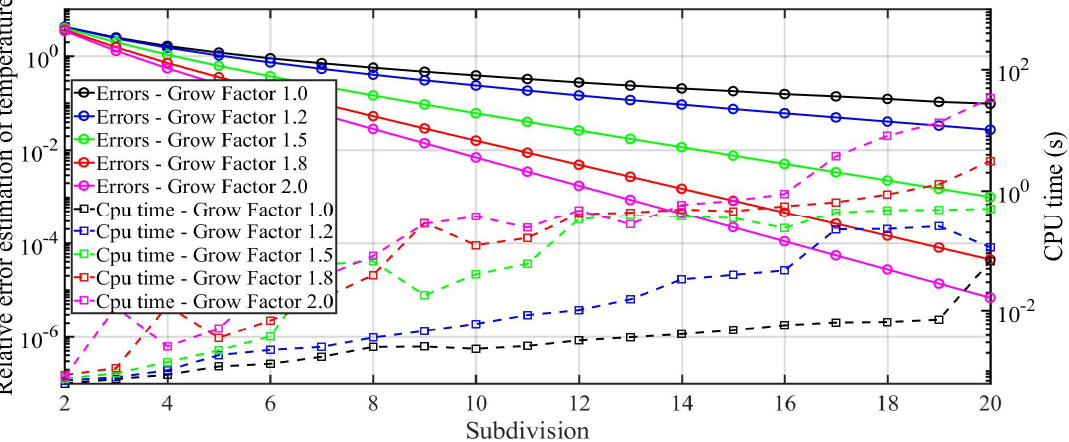
Figure 10. Relative maximum temperature error estimations of the inner surface (Case 1).